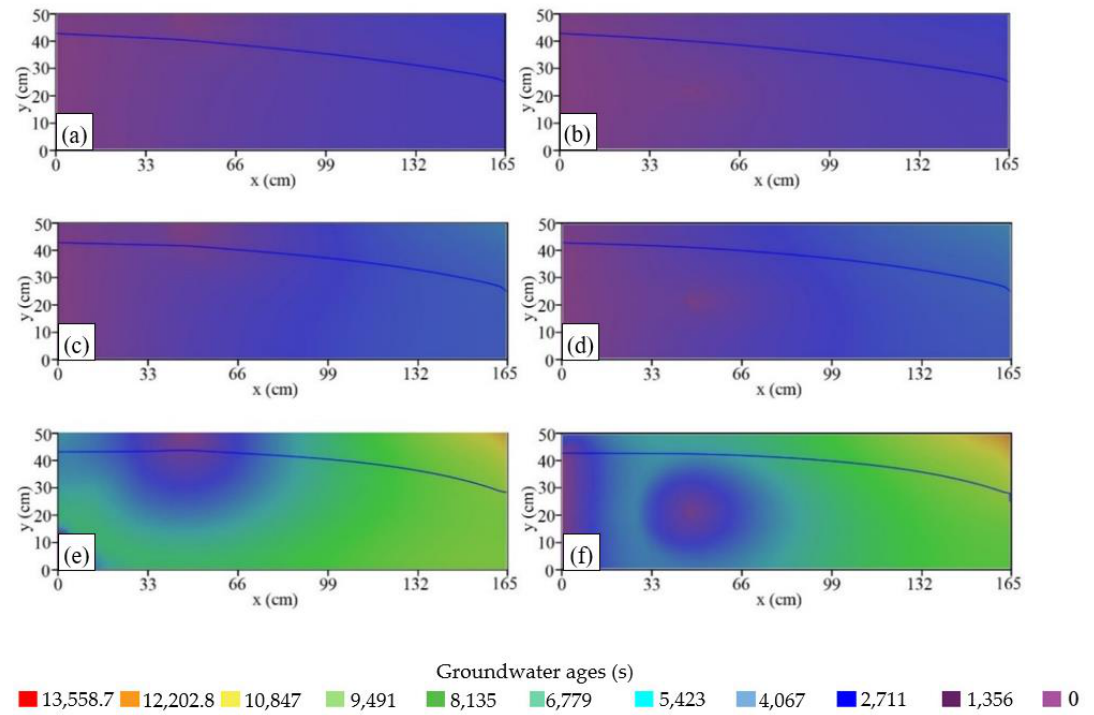
Figure 10. Groundwater age driven by artificial recharge through the infiltration basin (left side figures) and injection well IW3 (right side figures) with different length-decay exponents. The length-decay exponents in ( a ) and ( b ) were set to 0.005 m −1 . The length-decay exponents in ( c ) and ( d ) were set to 0.01 m −1 . The length-decay exponents in ( e ) and ( f ) were set to 0.02 m −1 . The blue lines in the figures represent the water table.